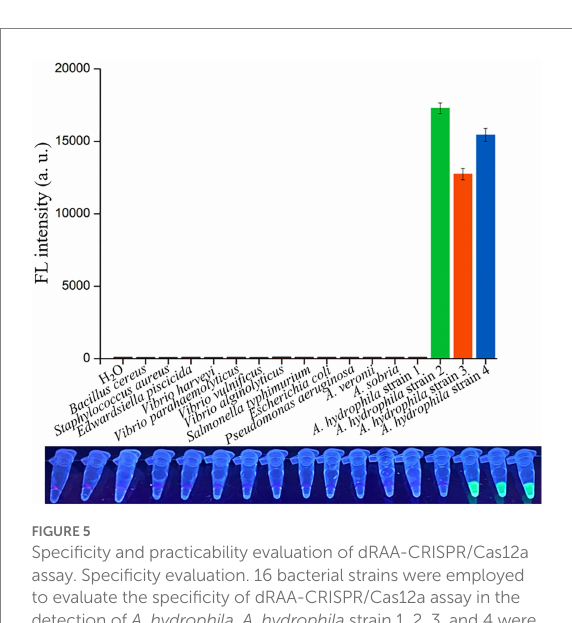
FIGURE 5 Specificity and practicability evaluation of dRAA-CRISPR/Cas12a assay. Specificity evaluation. 16 bacterial strains were employed to evaluate the specificity of dRAA-CRISPR/Cas12a assay in the detection of A. hydrophila . A. hydrophila strain 1, 2, 3, and 4 were aerA − hlyA − , aerA + hlyA − , aerA − hlyA + , and aerA + hlyA + , respectively. H 2 O was used as a negative control. n = 3 technical replicates; bars represent mean ±